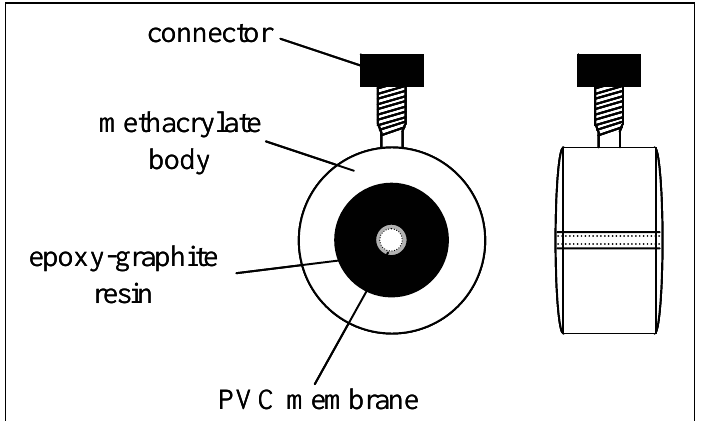
Figure 3. Design of the flow-through tubular electrode used in the SIA system.